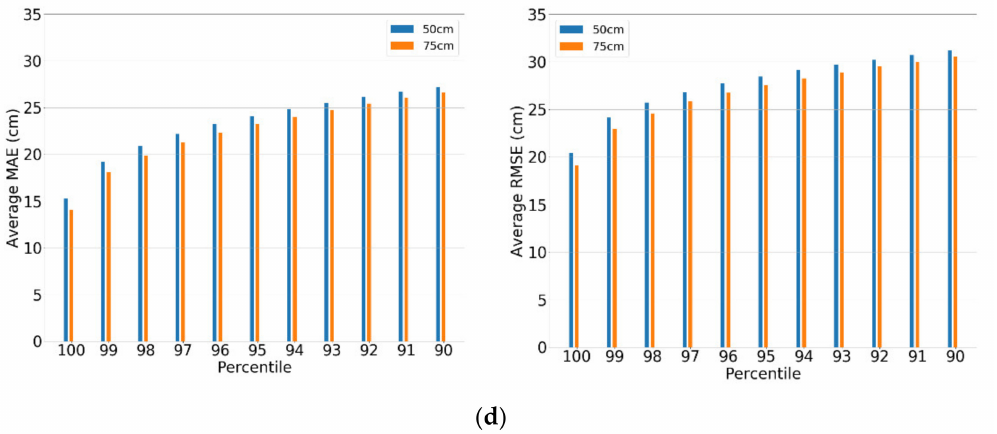
Figure 6. Bar plot of average MAE (cm) and average RMSE with the 100th–90th percentile of ( a ) cabbage; ( b ) pumpkin; ( c ) barley; and ( d ) wheat, with different buffer size used in the intercropping experimental field over growing season.